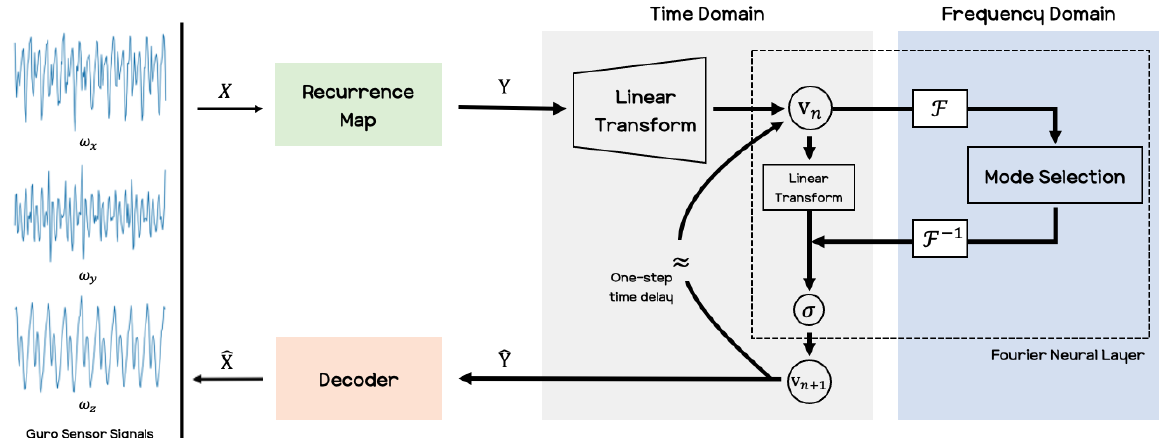
Figure 2. Pipeline schematic of our proposed method for predicting upcoming human motion signals. The linear transform lifts the recurrence plot to a high-dimensional representation or performs a linear combination of the features. A Fourier neural layer composed of a Fourier transform, F , and its inverse, F − 1 , crosses between the time domain and the frequency domain, and it extracts features by removing unnecessary frequencies from the mode selection. Then the output of the Fourier neural layer is given as v n + 1 which is applied to the sigmoid function, σ